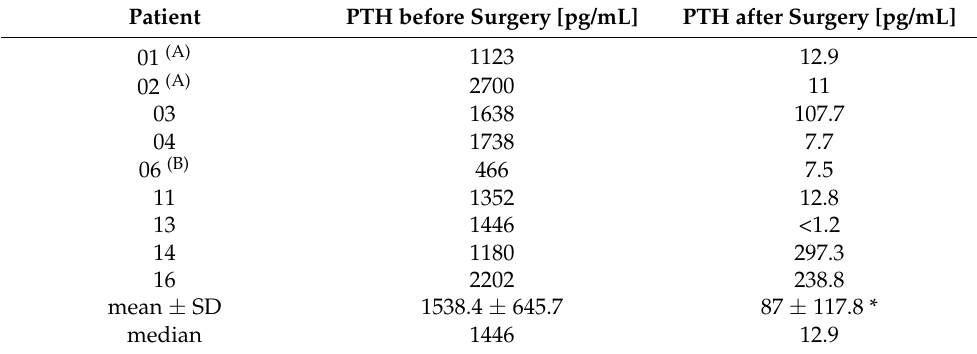
Table 2. Serum PTH concentration before PET/CT with [ 11 C]MET and after surgical